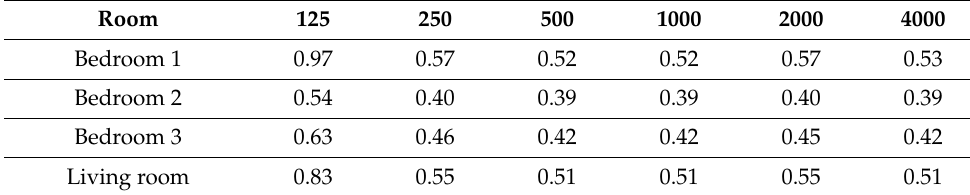
Table 8. Four-room apartment reverberation time T 20 considered in the simulation.